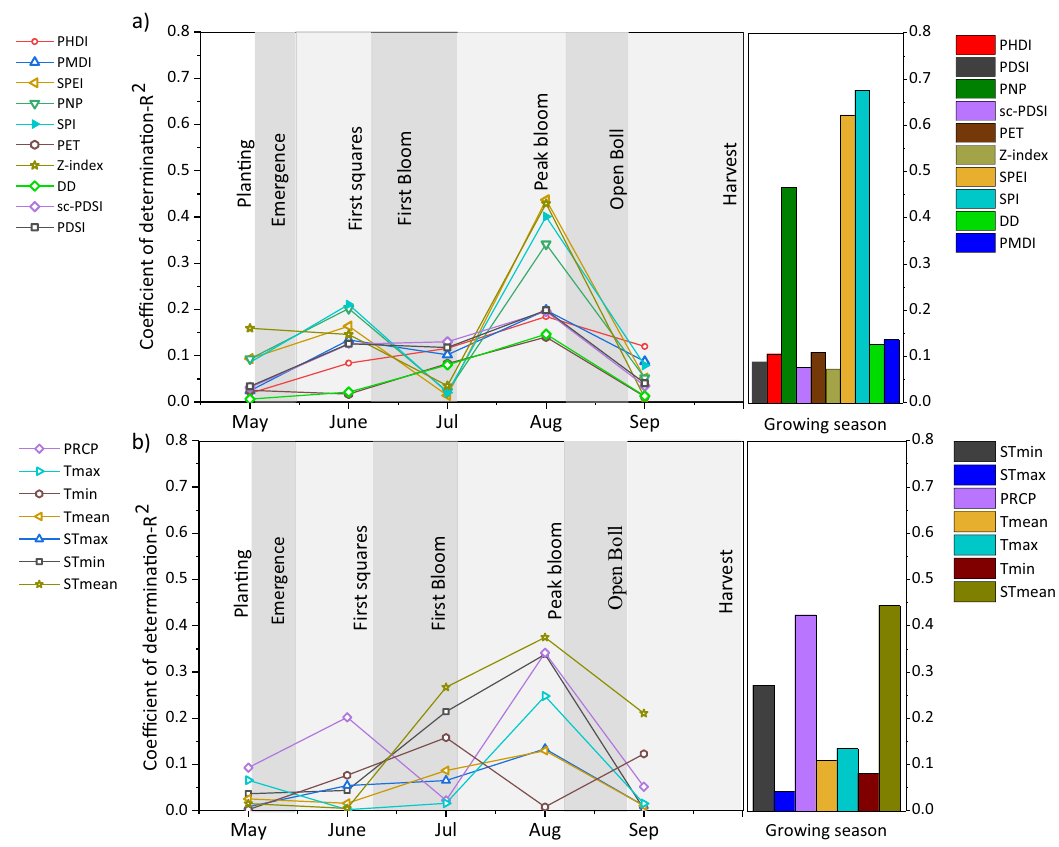
Fig. 1 The coef fi cients of determination for quadratic regressions, explaining yield variability based on the monthly and seasonal variability of drought indices and raw climate variables. The R 2 values represent the strength of the relationship between annual mean crop yield and monthly and cumulative growing season (GS) values of a drought indices, including standardized precipitation index (SPI), standardized precipitation evapotranspiration index (SPEI), palmer drought severity index (PDSI), self-calibrated palmer drought severity index (sc-PDSI), palmer hydrological drought index (PHDI), palmer moisture anomaly index (Z-index), palmer modi fi ed drought index (PMDI), and percentage of normal precipitation (PNP) and b raw climate variables including cumulative precipitation (PRCP), maximum temperature (Tmax), minimum temperature (Tmin), mean temperature (Tmean), maximum soil temperature (STmax), minimum soil temperature (STmin), and mean soil temperature